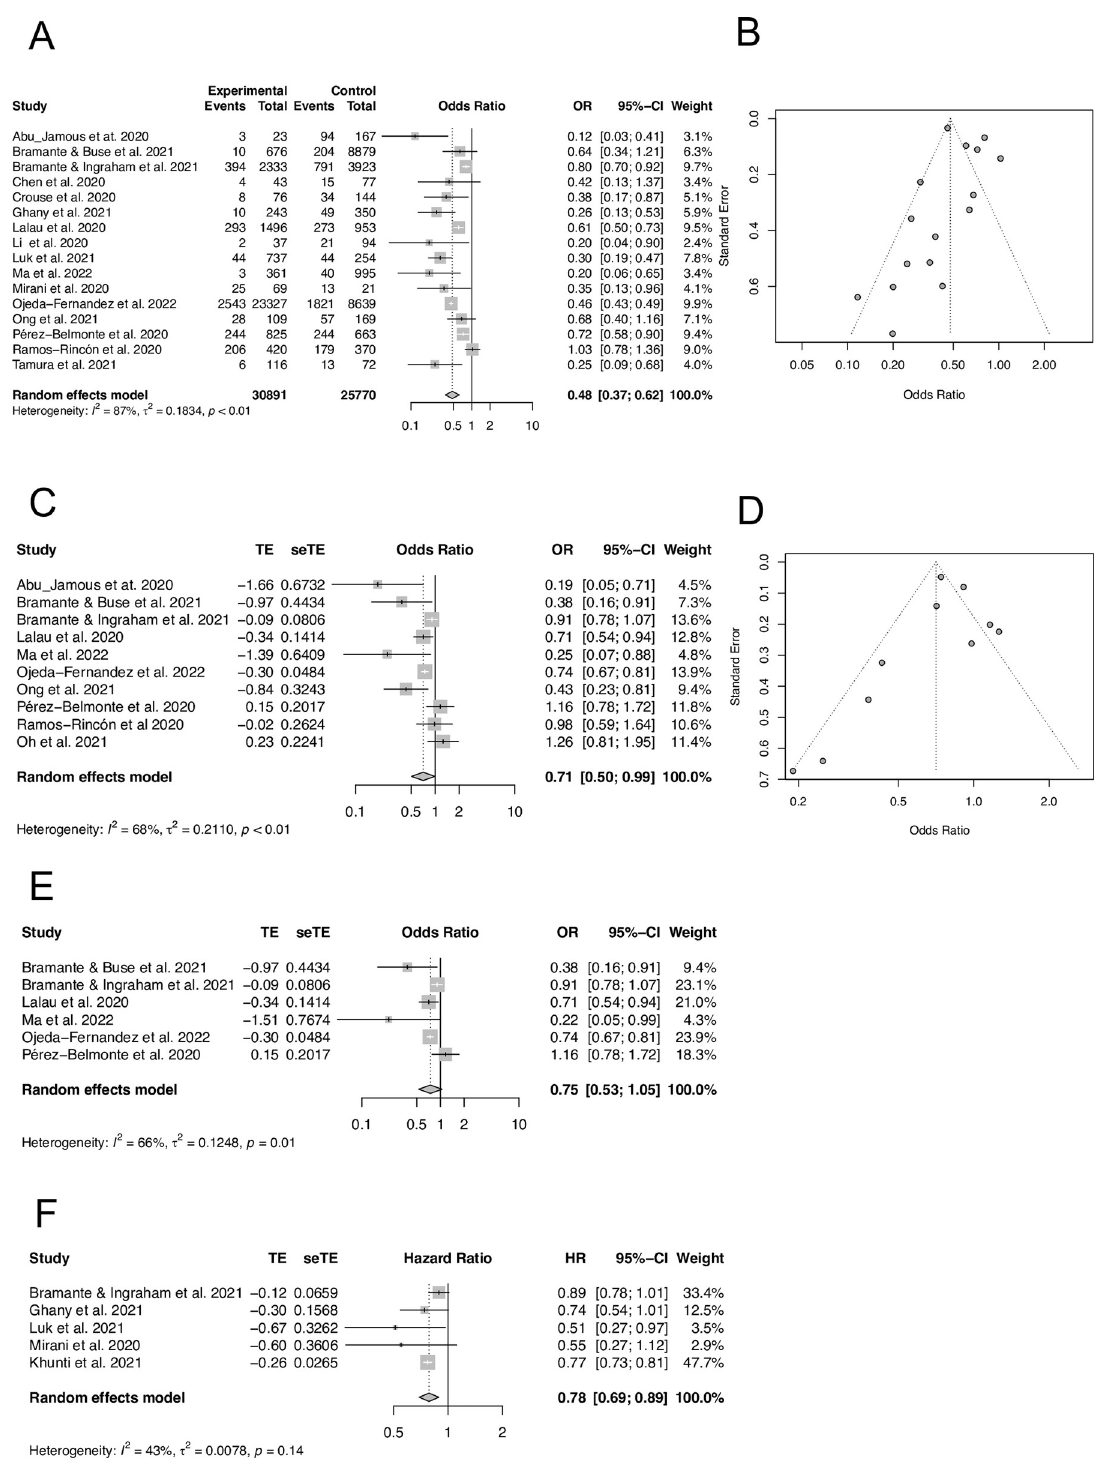
Fig 2. The association of outpatient metformin use and in-hospital mortality in patients with COVID-19 and pre-existing T2DM. (A) Meta-analysis of 16 selected studies with extractable raw event data using the Mantel-Haenszel approach. (B) Funnel plot test of 16 studies included in panel A. (C) Meta-analysis of 10 selected studies with multivariable or propensity score-adjusted OR using the inverse-variance method to pool effect sizes. (D) Funnel plot of 10 studies included in panel C. (E) Meta-analysis of OR for in-hospital mortality in 6 studies with propensity score matched for metformin use by the inverse-variance method. (F) Meta-analysis of 5 studies with adjusted HR for in-hospital mortality using the inverse-variance method. https://doi.org/10.1371/journal.pone.0282210.g002 PLOS ONE | https://doi.org/10.1371/journal.pone.0282210 February 23,